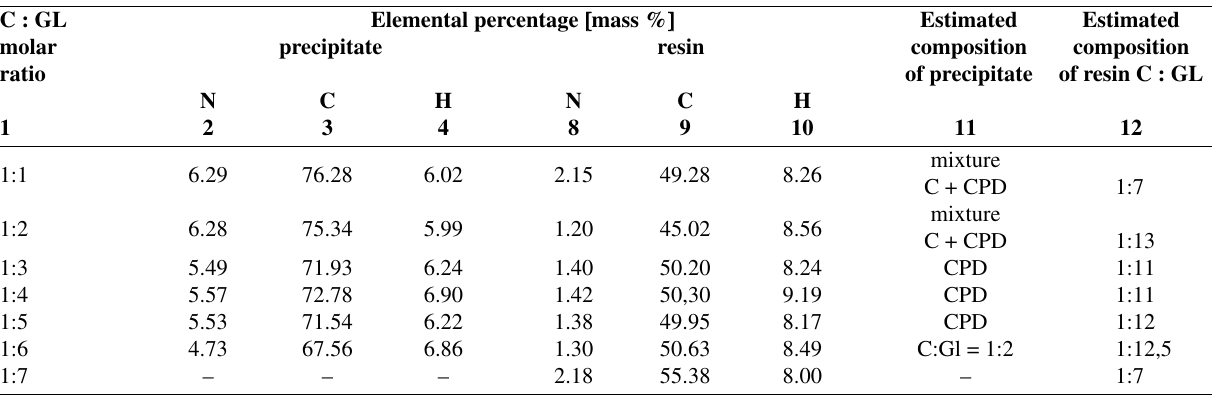
Table 2. Elemental analytical results of products of reaction of carbazole with glycidol C : GL